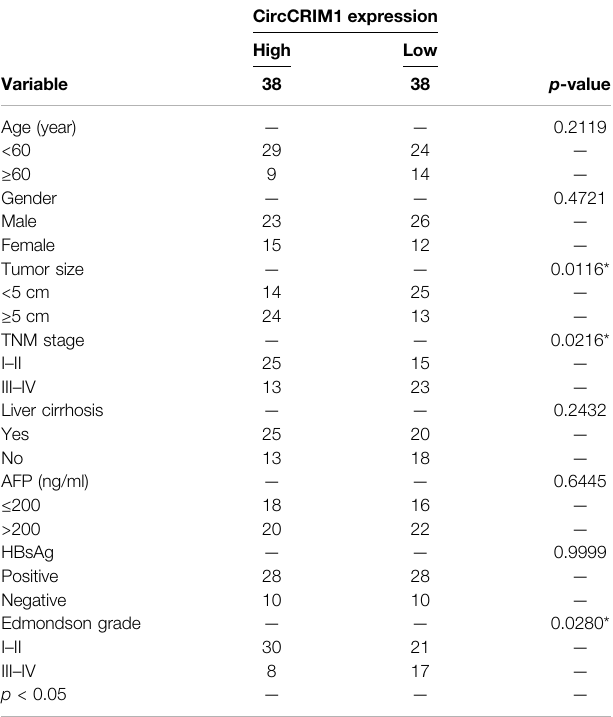
TABLE 1 | Correlation between circCRIM1 expression and clinicopathological features in HCC tissues ( n (cid:2) 76, χ 2 -test). CircCRIM1